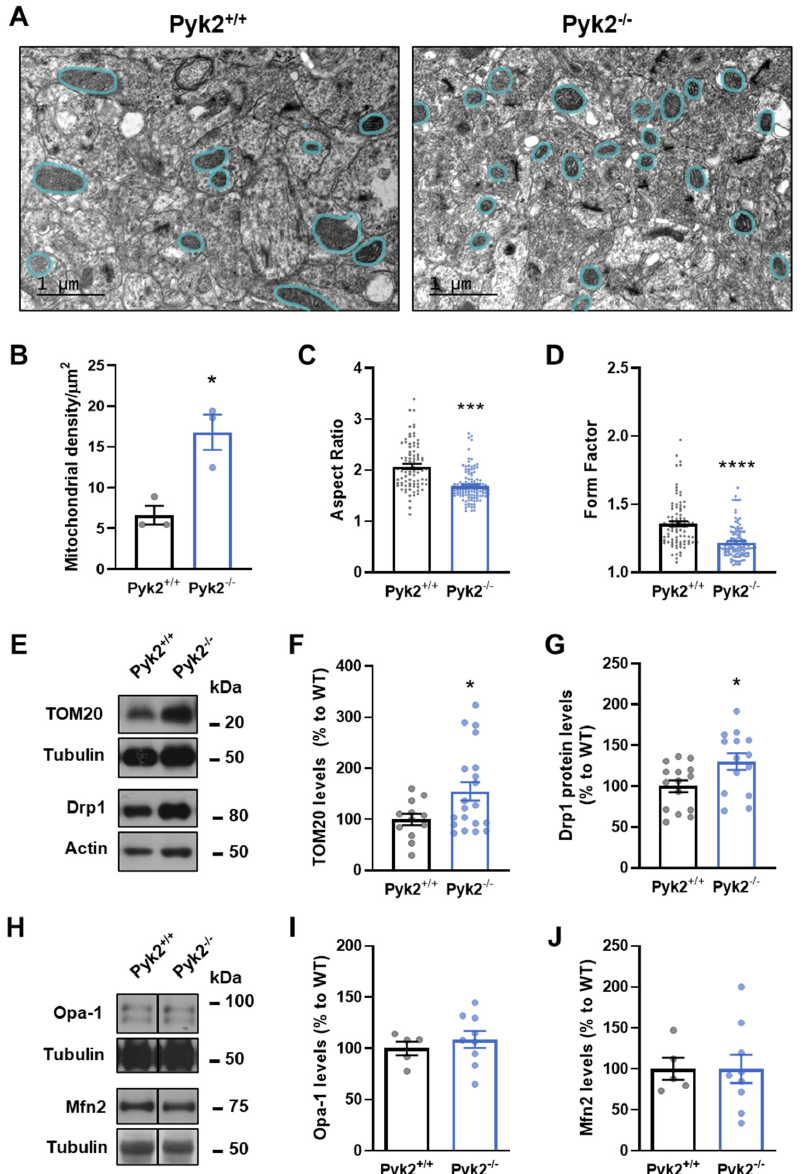
Figure 5. Mitochondrial dynamics and related proteins in hippocampus of Pyk2 − / − mice. ( A ) Representative electron microscopy images of pyramidal neurons in hippocampal tissue sections from Pyk2 +/+ (left panel) and Pyk2 − / − (right panel) mice. Blue lines delimit mitochondria. Scale bar, 1 µ m; ( B ) Mitochondrial density quantification in Pyk2 +/+ and Py2 − / − hippocampal pyramidal neurons from ( A ); Aspect Ratio ( C ), Mann–Whitney test, ( A , B ) = 11,883, 9438, U = 2298; p < 0.0001) and Form Factor; ( D ), Mann–Whitney test, A,B = 11,769, 9552, U = 2412; p < 0.0001) of results in ( A ) were also determined; ( E – G ) Immunoblotting and its quantification of TOM20 (( E , F ), Student t -test, t = 2.175, df = 30; p < 0.05) and Drp1 (( E , G ), Student t -test, t = 2.455, df = 27; p < 0.05) protein levels in dorsal hippocampus of Pyk2 +/+ and Pyk2 − / − mice; ( H – J ) Immunoblotting and its quantification of Opa-1 (Student t -test, t = 0.7007, df = 12; p = 0.4968) and Mfn2 (Student t -test, t = 0.0009984, df = 12; 0.9992) protein levels in hippocampus of Pyk2 +/+ and Pyk2 − / − mice. Actin or tubulin were used as loading control. Molecular weight markers positions are indicated in kDa in ( E , H ); Data represent mean ± SEM In ( C , D ), n = 87 Pyk2 +/+ and n = 119 Pyk2 − / − mitochondria from 3 different mice per group; Animals, in ( F ), Pyk2 +/+ n = 12 and Pyk2 − / − n = 16; in ( G ), Pyk2 +/+ n = 15 and Pyk2 − / − n = 14; in ( I , J ), Pyk2 +/+ n = 5 and Pyk2 − / − n = 9. * p < 0.05, *** p < 0.001, **** p < 0.0001 vs. Pyk2 +/+